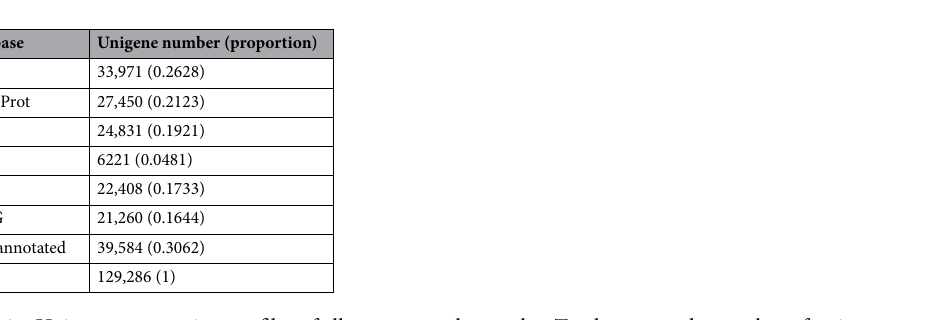
Table 2. Unigenes annotation profiles of all spongy moth samples. Total annotated = number of unigenes annotated in one or more databases.